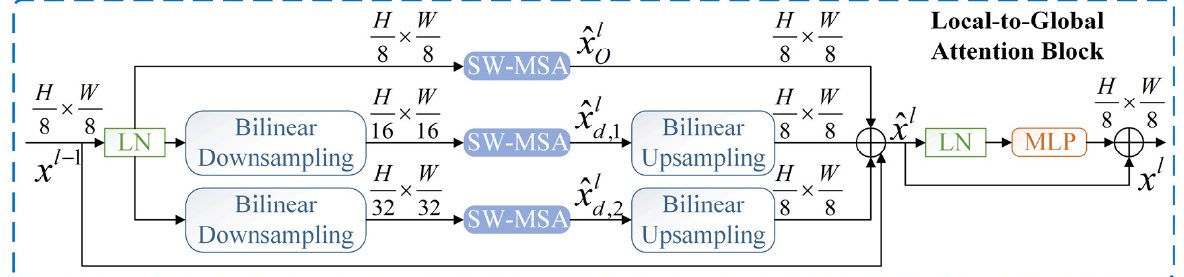
where DWConv is the depth-wise convolution operator.